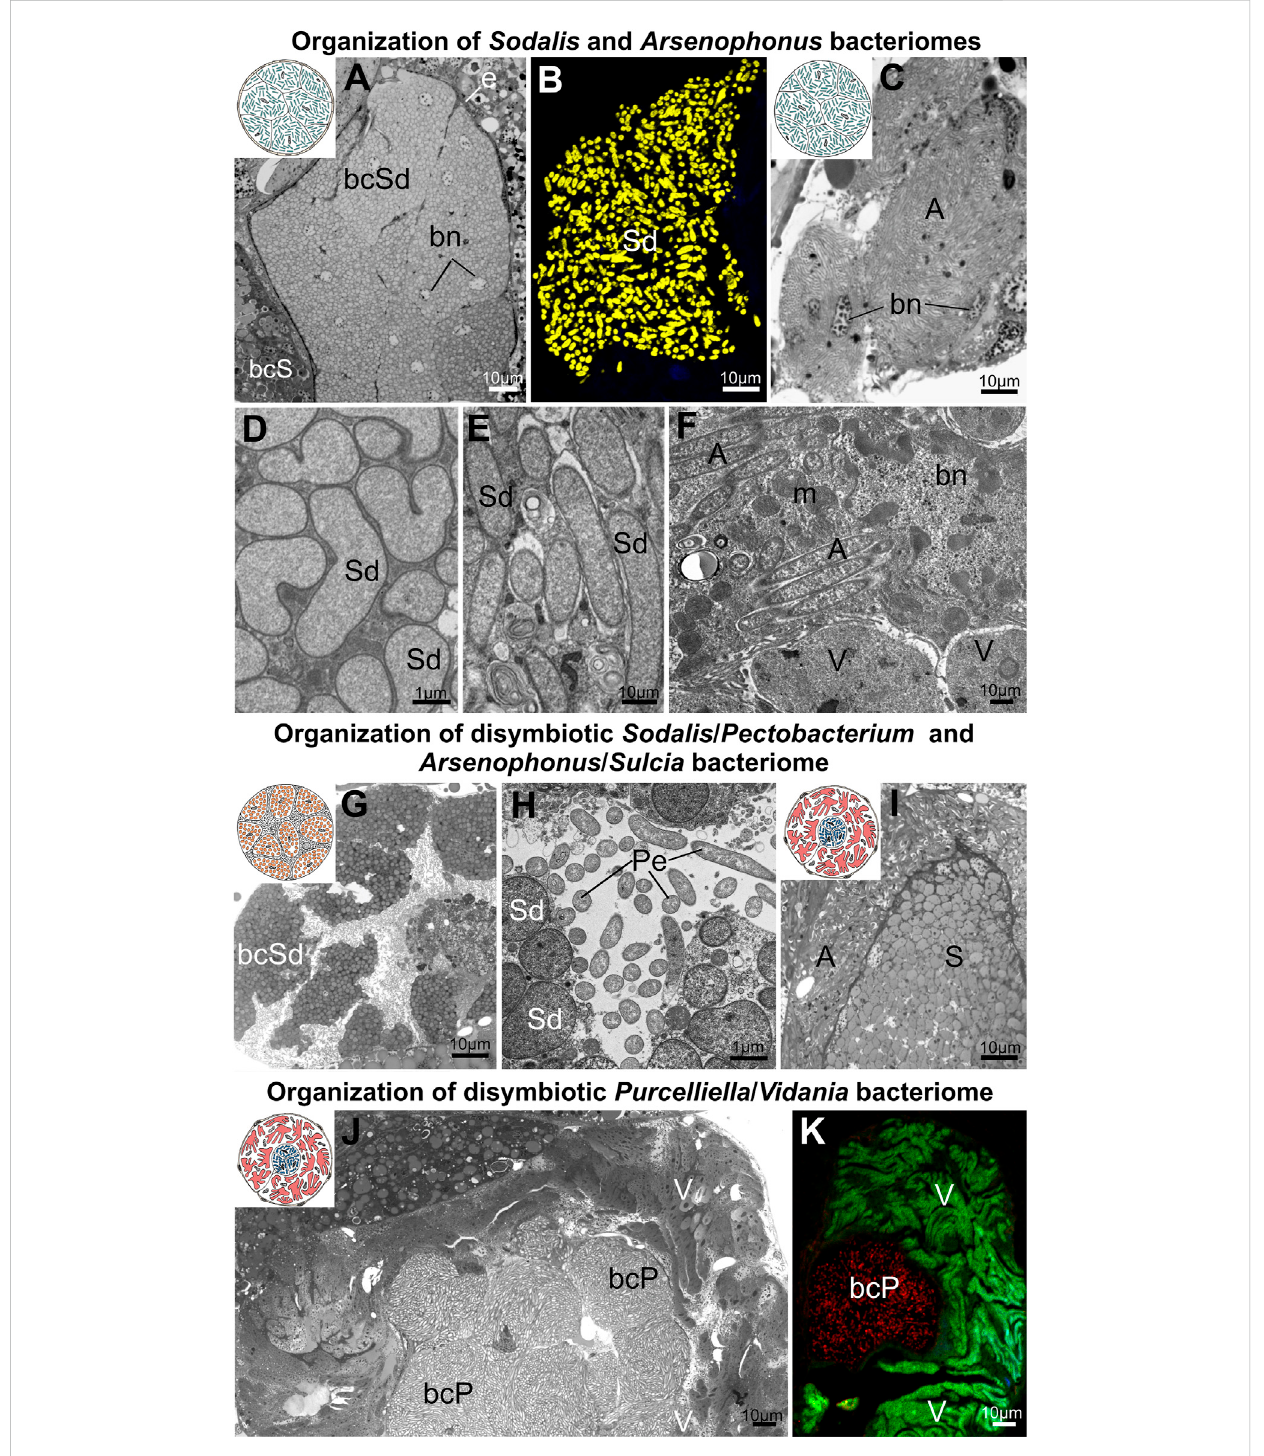
Organization of bacteriomes harboring gammaproteobacterial symbionts in planthoppers. (A,B) Organization of Sodalis bacteriome (C) Cluster of Arsenophonus bacteriocytes, (D,E) Ultrastructure of Sodalis cells (F) Arsenophonus cells in the cytoplasm of Vidania bacteriocyte. (G,H) Organization of disymbiotic Sodalis / Pectobacterium bacteriome. (I) Organization of disymbiotic Arsenophonus / Sulcia bacteriome. (J,K) Organization of disymbiotic Purcelliella / Vidania bacteriome. For a detailed description of these images, see the main text. (A,C,G,H,I,K) Light microscope (LM). (B,H) Confocal microscope. (D,E,F,J) Transmission electron microscope (TEM).A - Arsenophonus , bcP - Purcelliella bacteriocyte, bcS - Sulcia bacteriocyte, bcSd - Sodalis bacteriocyte, bn - bacteriocyte nucleus, m - mitochondria, Pe - Pectobacterium , S - Sulcia , Sd - Sodalis , V - Vidania. Insect species: (A) Tshurtshurnella decempunctata (Issidae) (B) Tettigometra griseola (Tettigometridae) (C) Scorupella discolor (Issidae) (D) Zopherisca tendinosa (Issiade), (E) Kelisia ribauti (Delphacidae) (F) Scorupella discolor (Issidae) (G,H) Tettigometra sulphurea (Tettigometridae) (I) Pyrops clavatus (Fulgoridae) (J,K) Hyalesthes luteipes